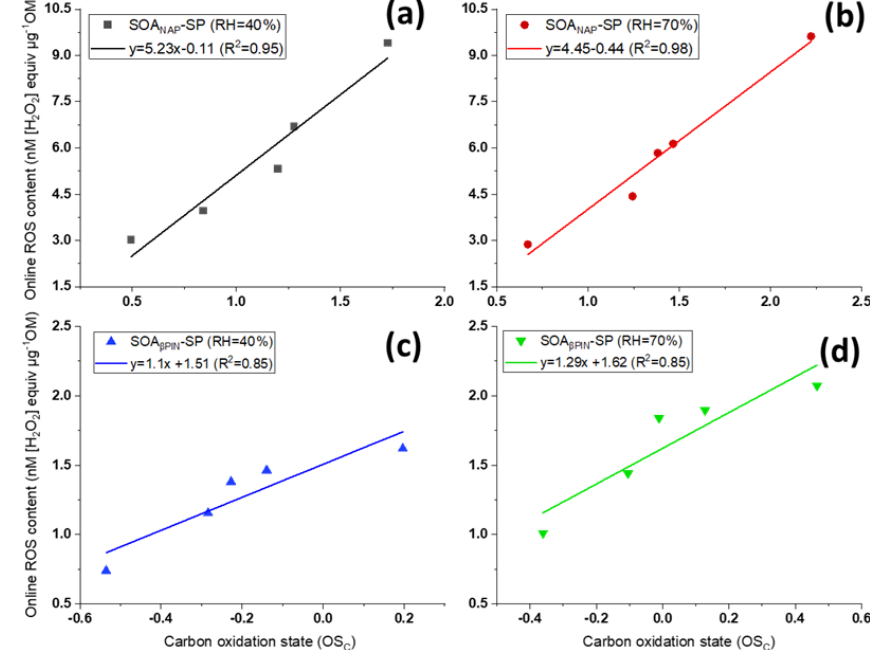
Figure 3. Positive correlations between carbon oxidation state (OS C ) of the particles and their ROS content using the online instrument OPROSI (in each of the panels, the data points from left to right correspond to 2, 3, 4, 5 and 9d photochemical aging) for SOA NAP -SP at 40% and 70% relative humidity, (a) and (b) , respectively, and for SOA β PIN -SP at 40% and 70% relative humidity, (c) and (d) , respectively. The data show that longer aging times increase the carbon oxidation state (OS C ) and the corresponding ROS content in SOA. The line indicates linear regressions between OS C and online ROS